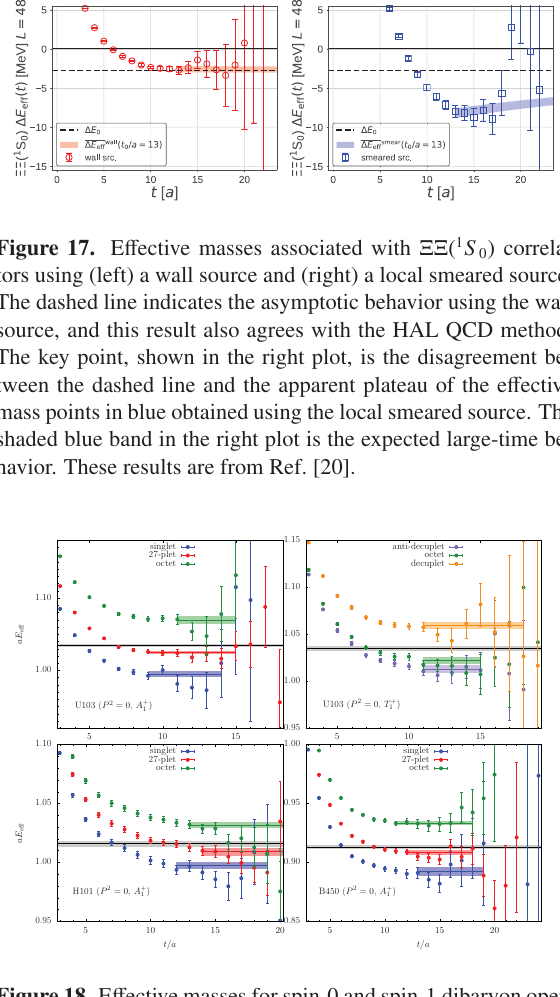
Figure 18. E ff ective masses for spin-0 and spin-1 dibaryon oper- ators of di ff erent flavor irreps using 3 ensembles from Ref. [21]. Blue points show flavor singlet results, the red points show the flavor 27-plet, and the flavor octet is shown in green. Results on spin-zero irrep are shown in the CLS U103 ensemble in the A + 1 the upper left. The upper right plot shows results on the U103 spin-one irrep. Results in the A + spin-zero ensemble for the T + 1 1 irrep on the H101 and B450 ensembles are shown in the lower left and lower right plots, respectively. Horizontal black lines show the two-octet baryon thresholds. The SU (3) flavor sym- metric point is used, and the lattice volumes are